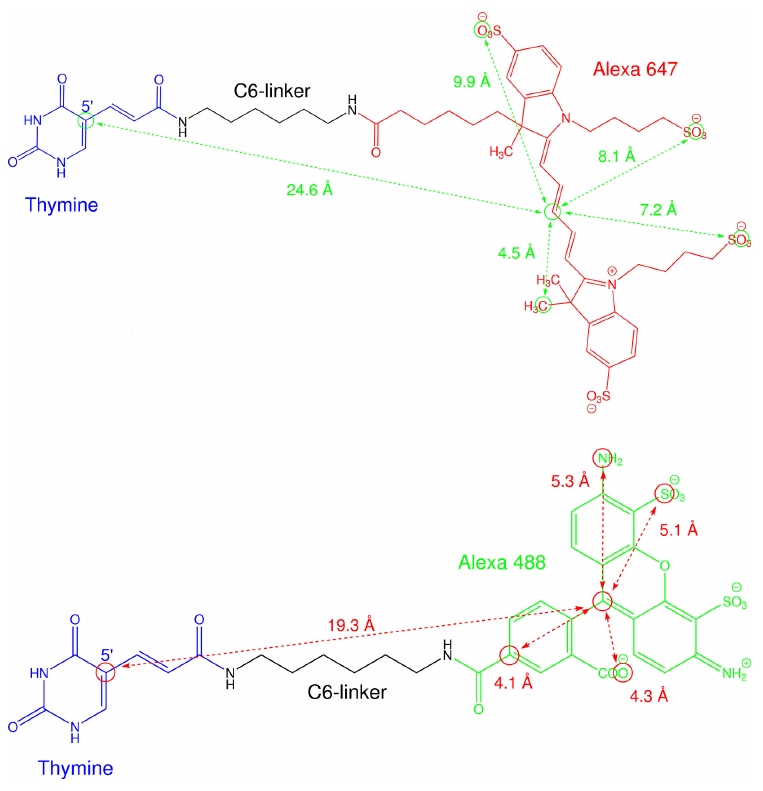
Figure 1. Chemical structure of two fluorophores used as a FRET pair (Alexa 647 in red and Alexa 488 in green) attached to DNA at position 5' of a thymine (T in blue) via a C6 amino linker (NH -C H -NH in black). The distances (given by the arrows) are employed 2 6 12 2 in Section 3.8 for coarse graining the